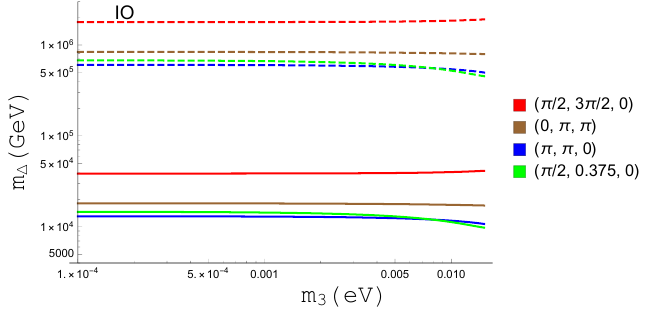
Figure 5 . Comparison plot of the maximum m ∆ probed by µ to e conversion in Ti nuclei tests at the SINDRUM experiment [103] (Dashed) and at the upcoming COMET experiment [26] (Solid) for different sets of neutrino CP phases ( δ CP , α 21 , α 31 ) and varying lightest neutrino mass, in the IO scenario. All other parameters are given by the best fit parameters in table